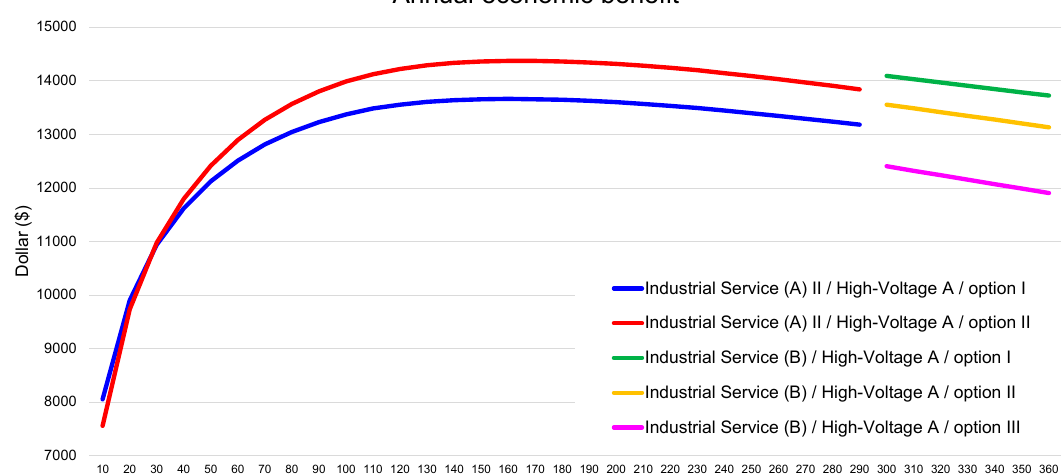
Figure 6. Annual economic benefit of each electric rate based on contract demand.